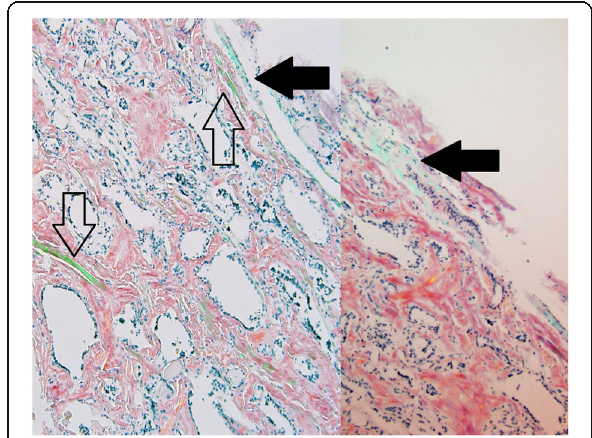
Fig. 5 Congo red stained slide images using standard microscope with an analyzer that has a build-in compensator. Blue hue (black arrows) compared to apple green (frame arrows). Sometimes this is caused by partial uncrossing of an analyzer with built in